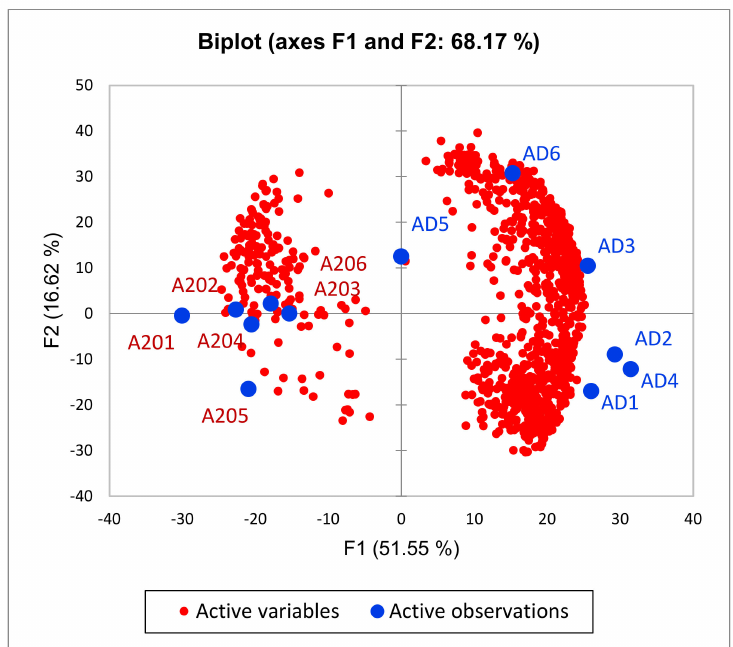
Figure 10. Total of 1009 DEGs across AD and A20 groups. A20 group maintained around 170 increased DEGs, while 839 DEGs featured attenuated expression in the A20